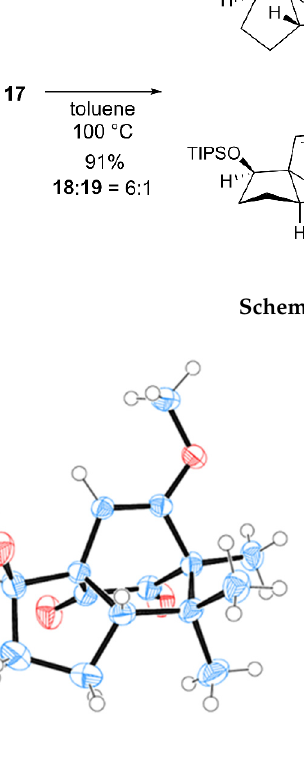
Figure 2. Ortep drawing of 20 and 22 .